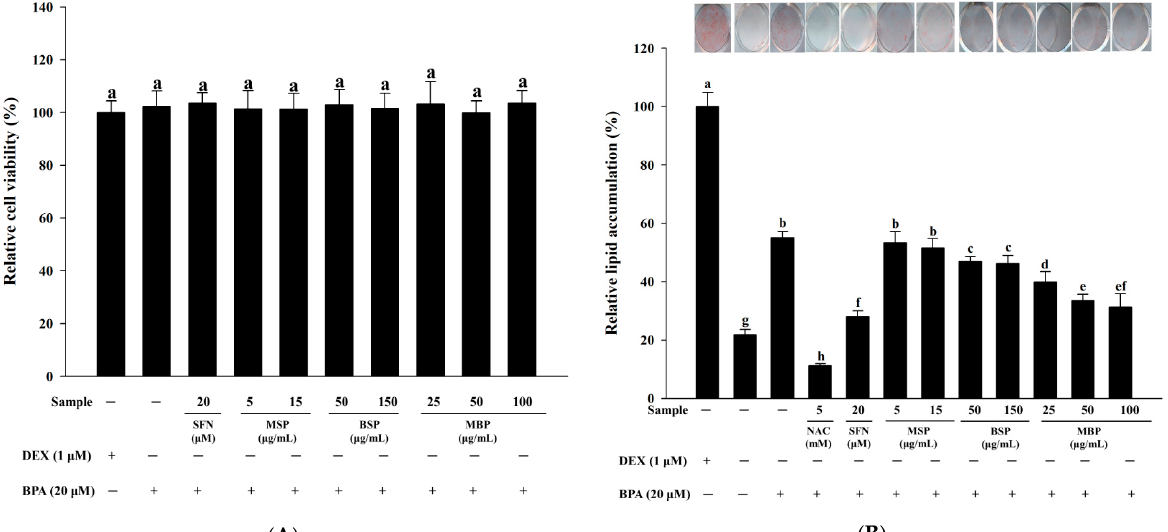
Figure 1. Effects of MBP, BSP, and MSP on cell viability and intracellular lipid accumulation in BPA-induced 3T3-L1 cells. Cell viability by XTT assay ( A ). Lipid accumulations were measured by ORO staining ( B ). Each value is expressed as mean ± SD of three independent experiments. Different lower letters on the bars indicate statistical differences at p < 0.05.